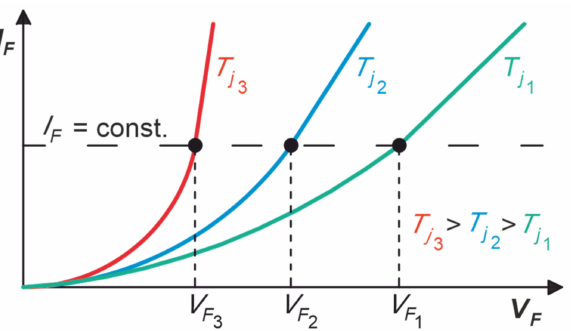
Figure 2. Relationship between forward voltage V F and forward current I F .